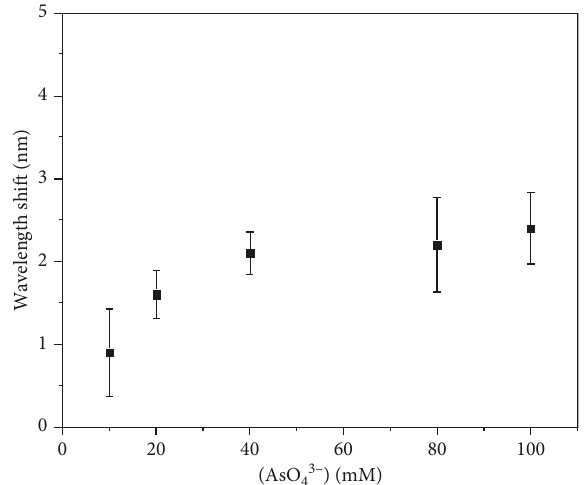
Figure 6: Preliminary analysis of arsenate by the LSPR